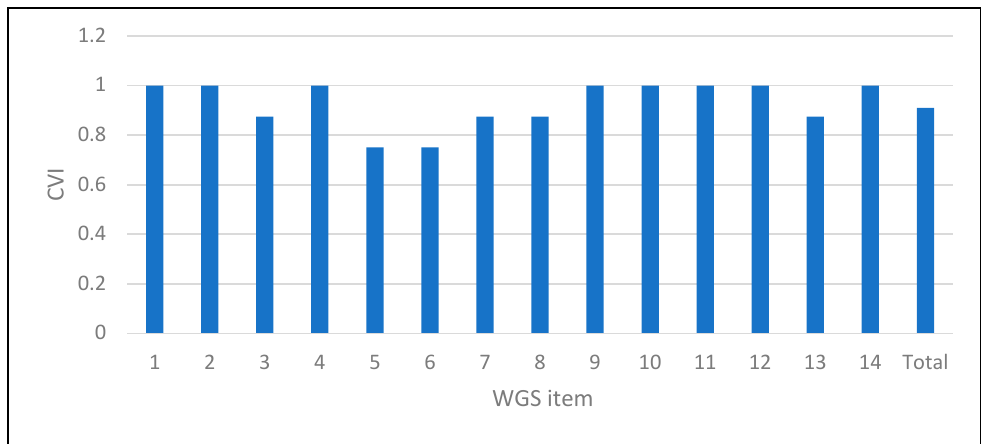
Figure 1. Content validity index of the WGS. CVI: content validity index.